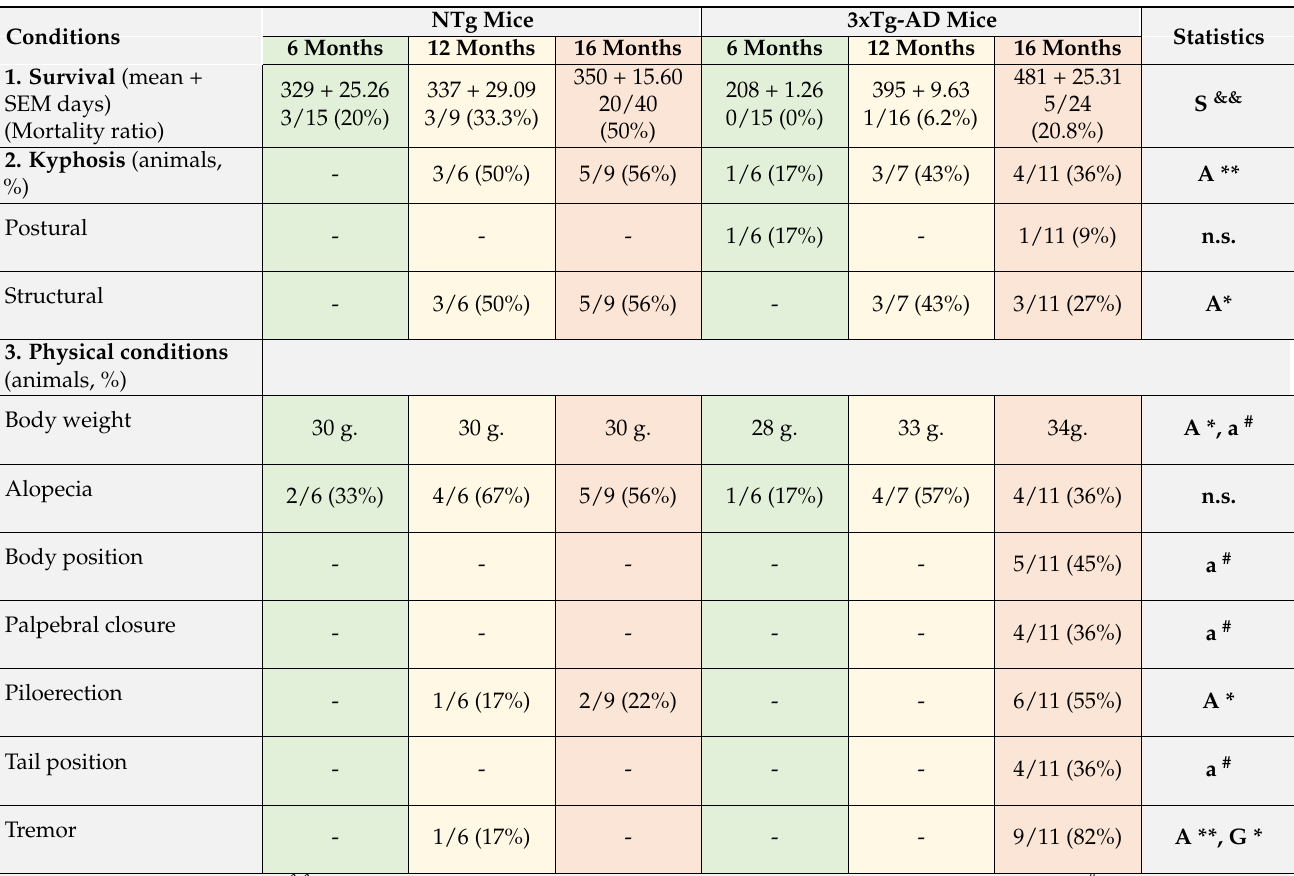
Table 3. Survival, kyphosis, and frailty phenotype.